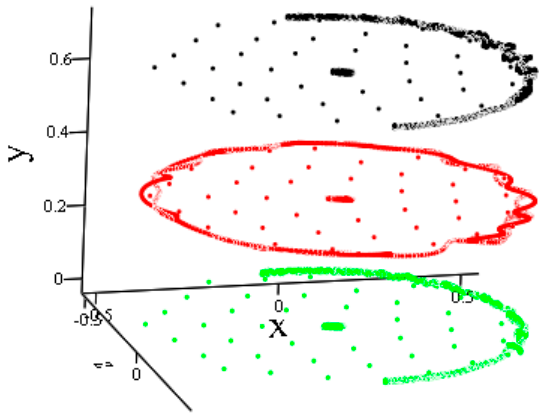
Figure 7. Trajectories of nodes located at the edges of three disks.